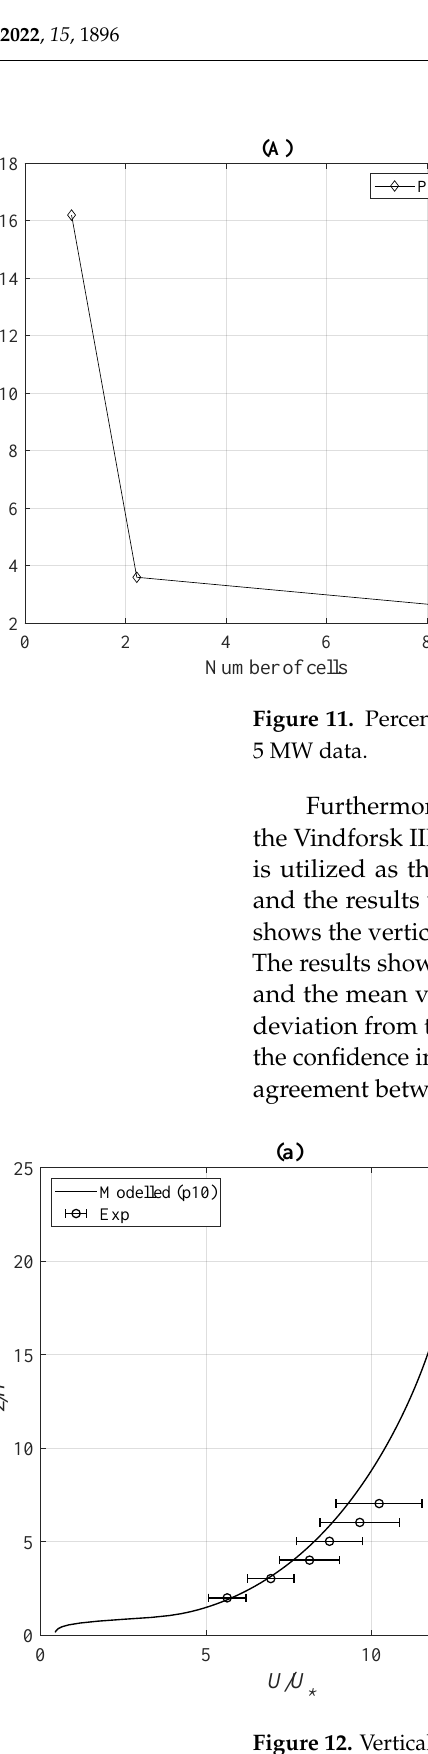
Figure 12. Vertical velocity ( a ) and TKE ( b ) profiles of the modeled case (H10) and the measurements taken from the